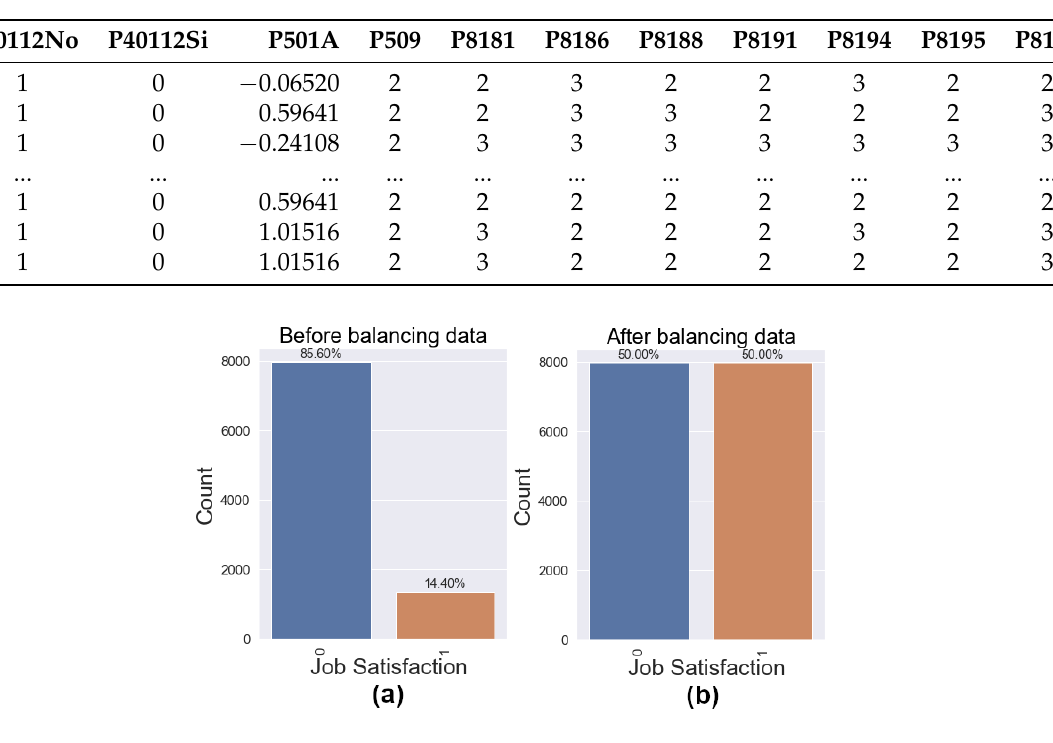
Table 3. Statistical summary of metrics in the training data set.